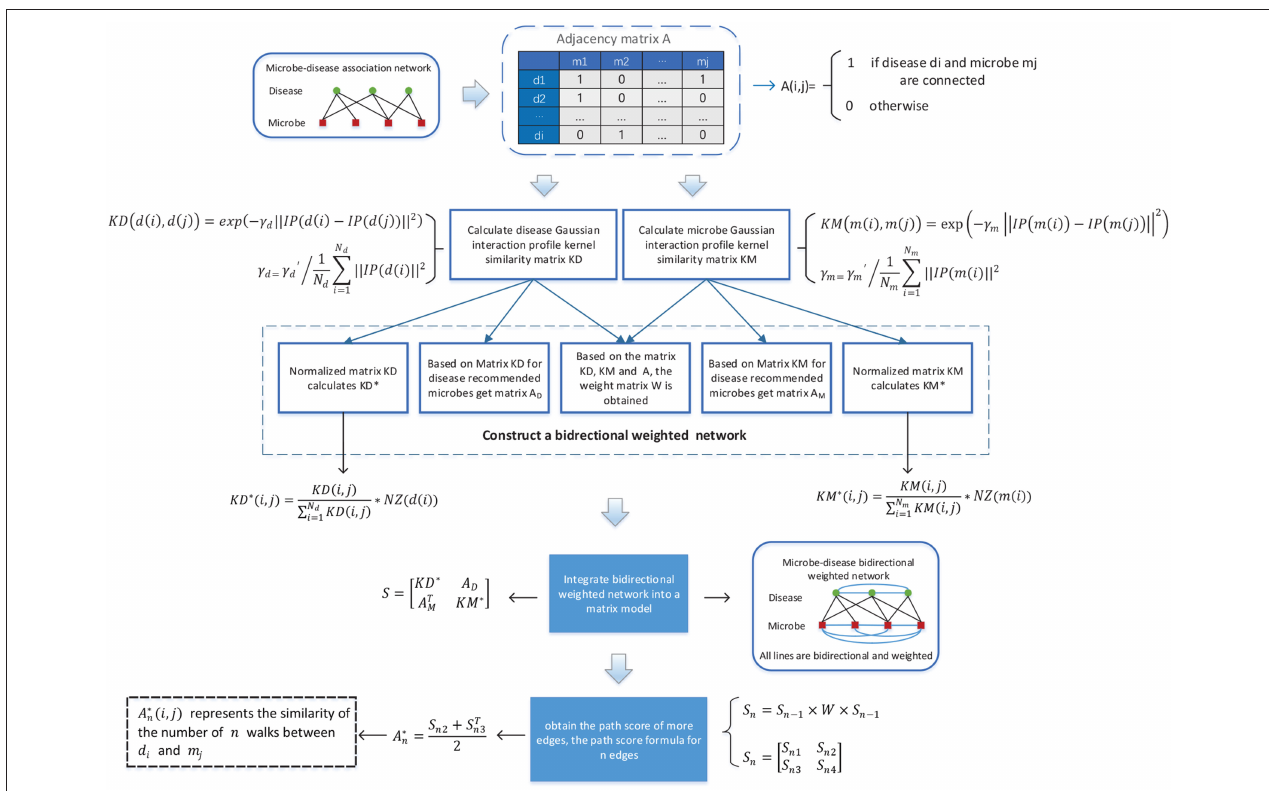
FIGURE 1 | Flowchart of